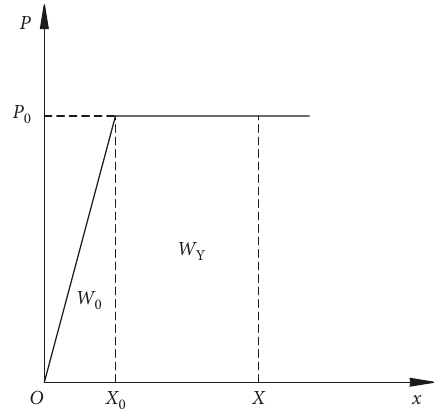
Figure 11: Energy balance relation curve of the NPR